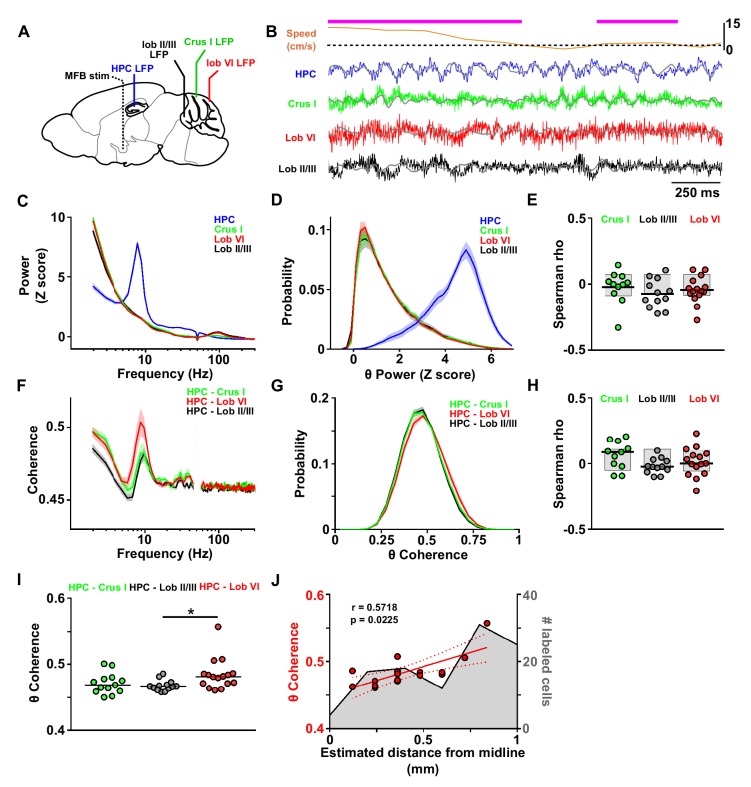
Assessment of cerebello-hippocampal interactions during active movement in the homecage.(A) Schematic representation of recording and stimulation electrode implant positions. (B) Representative simultaneous raw LFP recordings (colored lines) and LFP filtered in the theta frequency range (θ, 6–12 Hz, overlaid gray lines) recorded during active movement in the homecage condition as defined by instantaneous speed. Solid magenta line indicates data epochs in which speed was above the required threshold for inclusion in further analysis (3 cm/s, dashed line (20 mice). In one mouse in which speed data was not available we used neck electromyograph (EMG) data to define periods of active movement). (C) Averaged z-score of the power spectra from hippocampal LFP (n = 21, mean between left and right hemisphere LFPs when both recording electrodes were on target) and cerebellar cortical regions Crus I (n = 12), lobule II/III (n = 13) and lobule VI (n = 16) during homecage exploration (speed above 3 cm/s). (D) Probability distribution of the instantaneous z-scored theta power for each of the recorded regions. Hippocampal theta power followed a negatively skewed distribution while cerebellar theta power followed a positively skewed distribution. (E) Correlation between the instantaneous z-scored theta power for each of the cerebellar recorded regions and instantaneous speed. Horizontal line indicates mean. Gray-shaded bars represent the confidence levels obtained from bootstrapped data with α = 0.05. Theta power was not significantly correlated with speed in any of the cerebellar recordings (Crus I, n = 11; lobule II/III, n = 12; lobule VI, n = 15). (F) Averaged coherence between cerebellar cortical recordings (color coded) and hippocampus (when both hippocampal recording electrodes were on target we averaged the coherence obtained with left and right hemispheres; Crus I, n = 12; lobule II/III, n = 13; lobule VI, n = 16) during homecage exploration (speed above 3 cm/s). (G) Probability distribution of the instantaneous hippocampal-cerebellar theta coherence (color coded). All the recording combinations followed normal distributions. (H) Correlation between the instantaneous hippocampal-cerebellar theta coherence (color coded) and the instantaneous speed. Horizontal line indicates mean. Gray-shaded bars represent the confidence levels obtained from bootstrapped data with α = 0.05. HPC-cerebellar theta coherence was not significantly correlated with speed in any of the recording combinations. (I) Theta coherence between cerebellar recordings and hippocampus (average between coherence with left and right hemisphere LFPs when both recordings were on target; Crus I - HPC, n = 12; lobule II/III - HPC, n = 13; lobule VI - HPC, n = 16). Lobule VI-HPC coherence was significantly higher than that observed with lobule II/III (horizontal line indicates median coherence for each combination; *, Kruskal-Wallis with FDR correction, Kruskal-Wallis statistic = 6.75, p = 0.0342; lobule VI-HPC vs lobule II/III-HPC, p = 0.0246). J, Mean lobule VI-HPC theta coherence plotted against the estimated medio-lateral position of the recording electrode in lobule VI (red dots; n = 16, when both hippocampal recording electrodes were on target we averaged the coherence obtained with left and right hemispheres; Spearman rho = 0.5718, p = 0.0225). In gray, number of RABV+ cells counted across lobule VI 66 hr after injection in the left HPC as a function of medio-lateral position (0.2 mm bins; n = 5 mice). Shading indicates S.E.M. Abbreviations, LFP, local field potential; HPC, dorsal hippocampus; lob II/III, lobule II/III, lob VI, lobule VI, MFB stim, medial forebrain bundle stimulation.10.7554/eLife.41896.015Figure 3—source data 1.Assessment of cerebello-hippocampal interactions during active movement in the homecage.